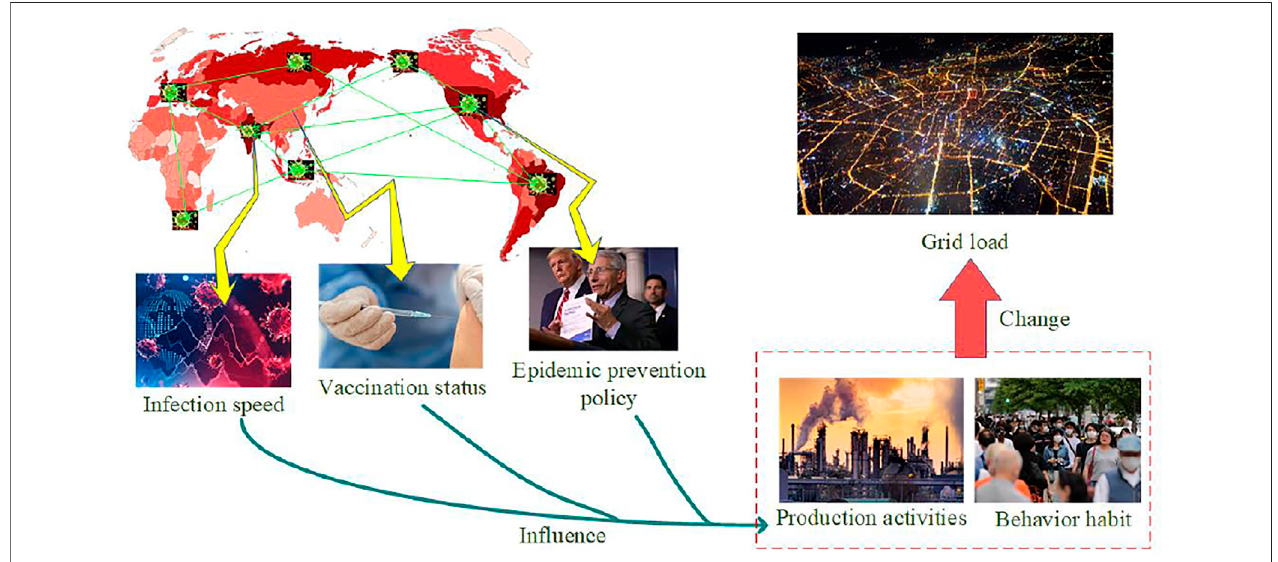
FIGURE 2 | Schematic diagram of the impact of COVID-19 pandemic on power grid load.